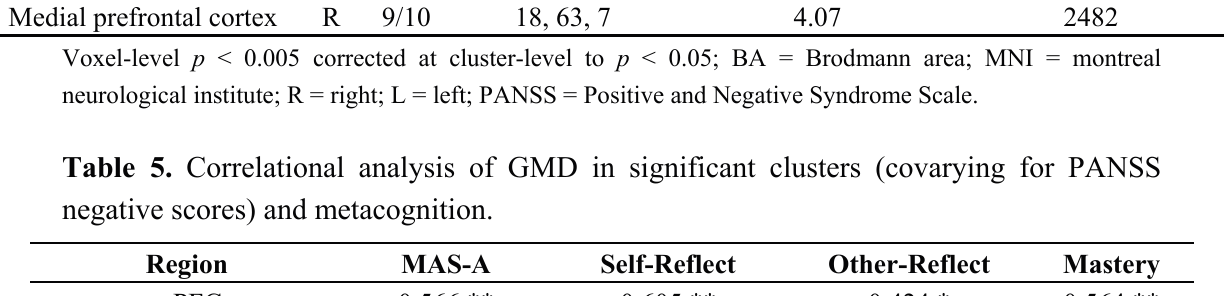
Table 4. Whole-brain gray matter volume results, covarying for PANSS negative scores . MNI Coordinates t -Value (Peak Voxel) Cluster Size (Voxels) Region R/L BA ( x , y , z )